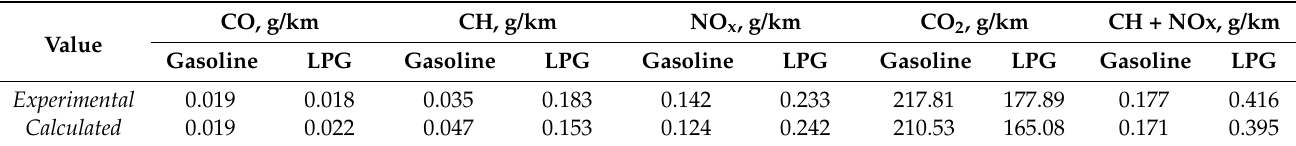
Table 3. Values of mass emissions of harmful substances per